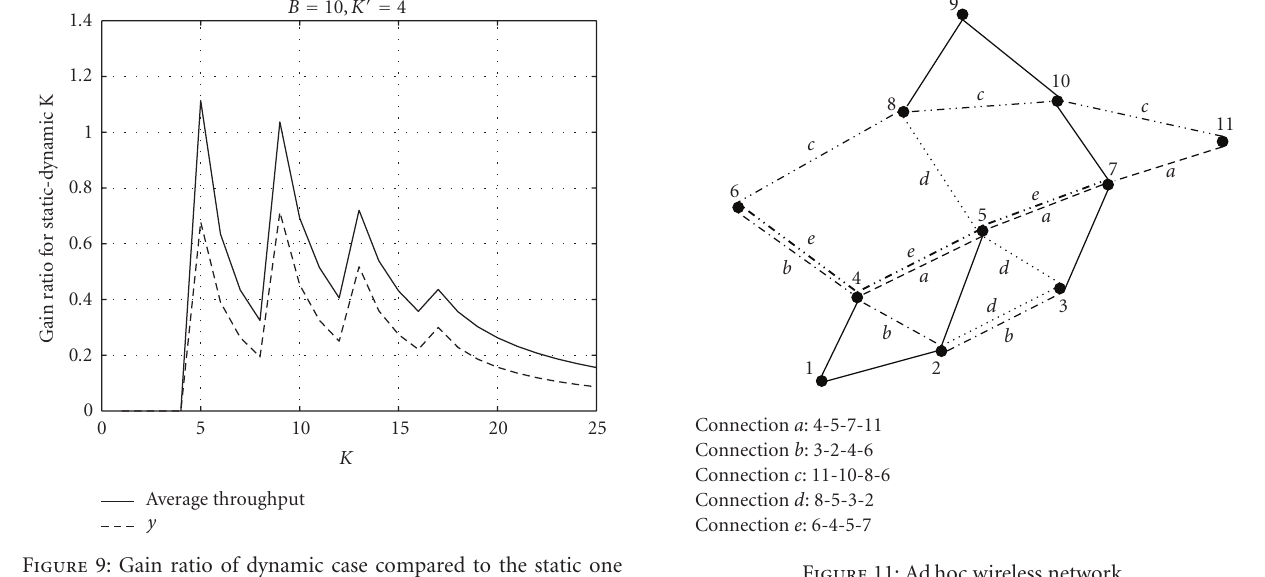
Figure 11: Adhoc wireless network.